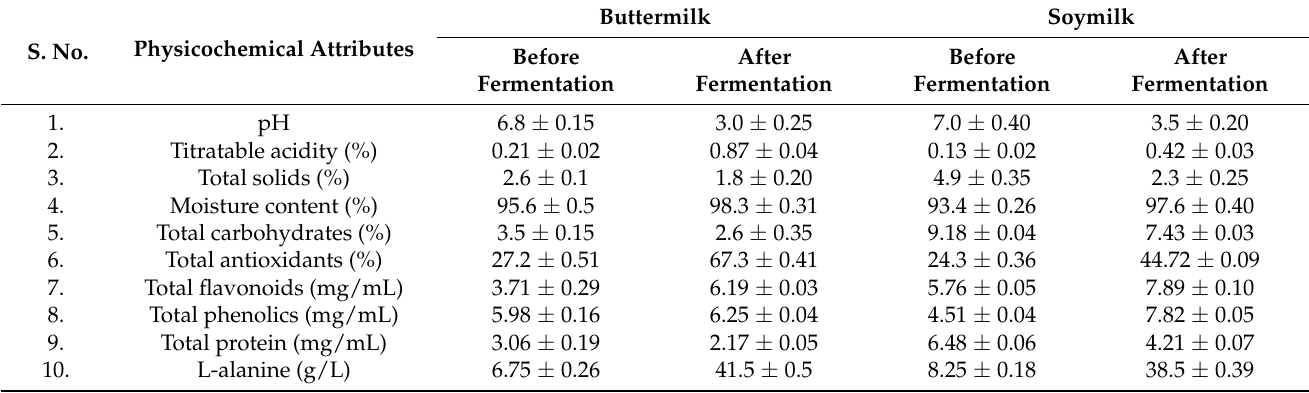
Table 1. Changes in the physicochemical attributes of the buttermilk and soymilk after LAB fermentation.